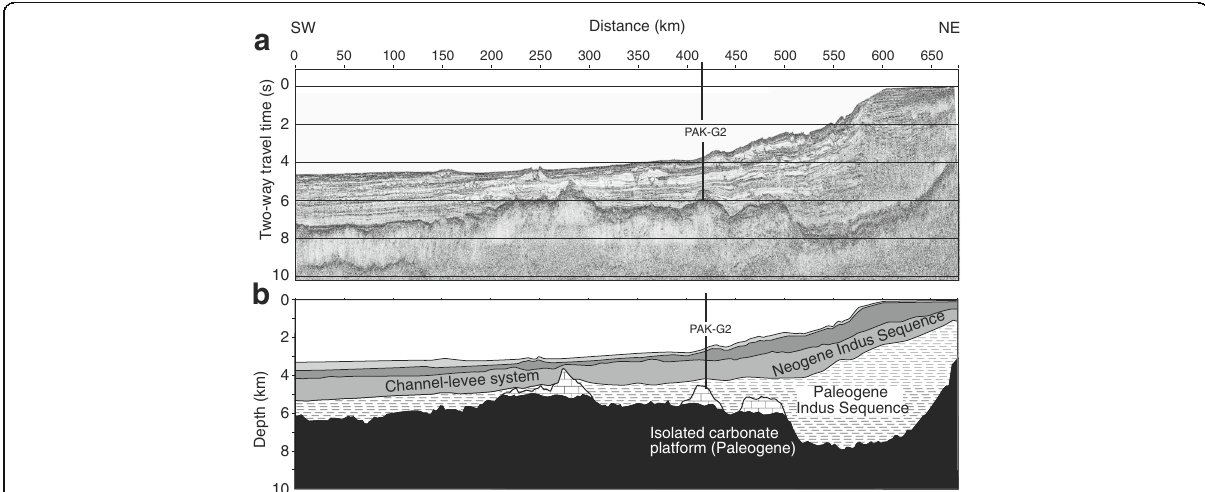
Fig. 4 NE-SW oriented seismic line TEPP207 through well PAK-G2, showing the original and interpreted sections. Modified from Calvès et al. (2008). See Fig. 2 for